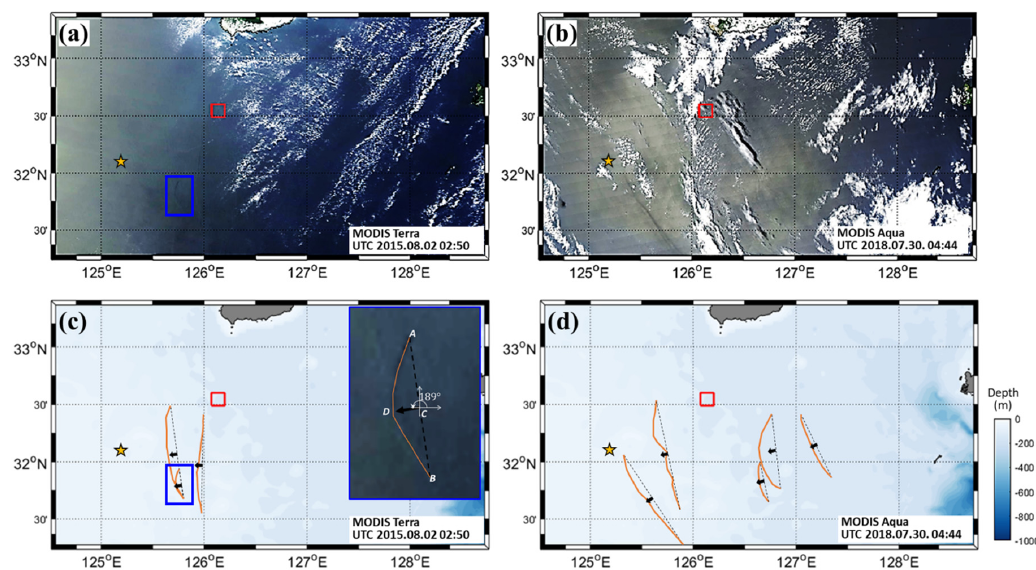
Figure 3. ( a , b ) Two satellite images where ( c , d ) surface manifestations of NLIWs (orange lines) are confirmed, from MODIS Terra at 02:50 UTC on 02 August 2015, and MODIS Aqua at 04:44 UTC on 30 July 2018. The blue box is the example of the propagation direction calculation. The SAVEX15 and IORS are marked by a red box and yellow star, respectively.